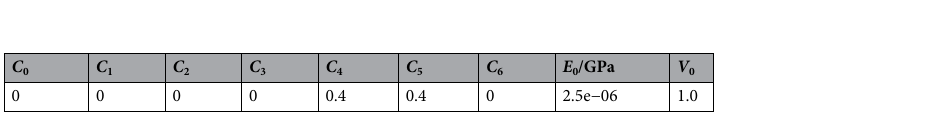
Table 3. EOS linear polynomial parameters. E 0 is the initial internal energy per unit reference for a specific volume, and V 0 is the initial relative